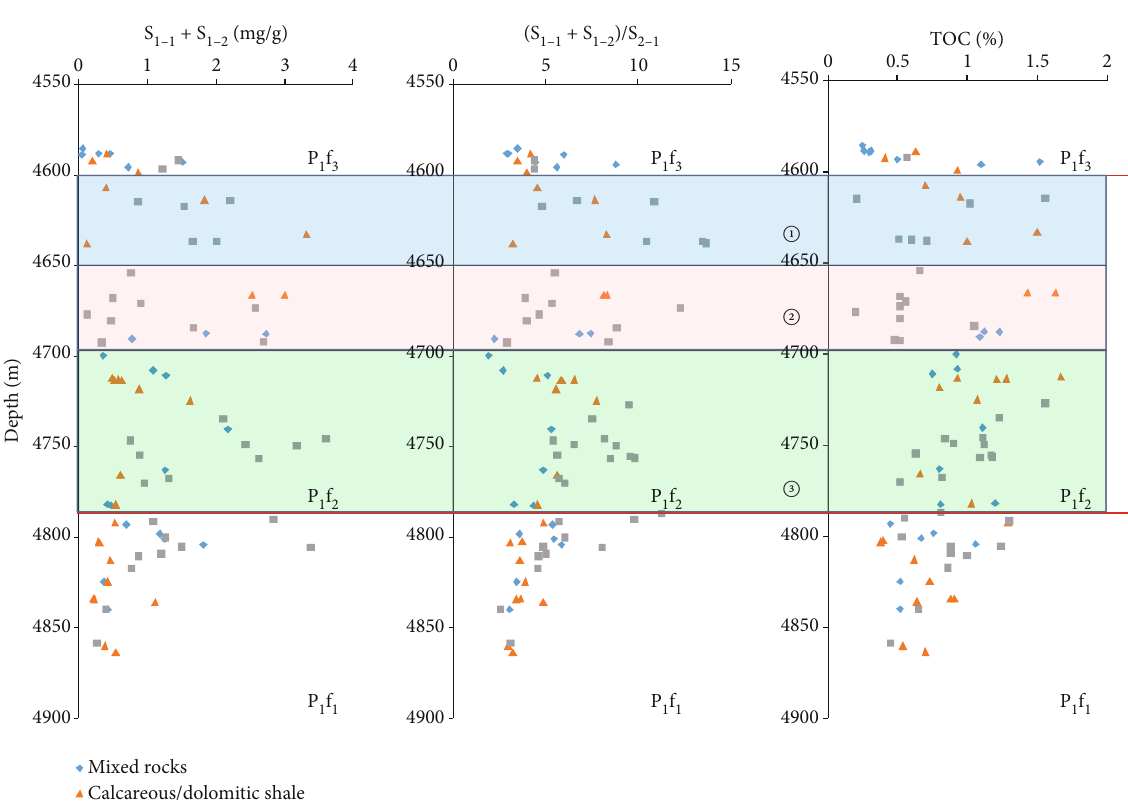
Figure 15: Relationship between free oil, adsorbed oil, and mineral composition in the Fengcheng Formation shale.